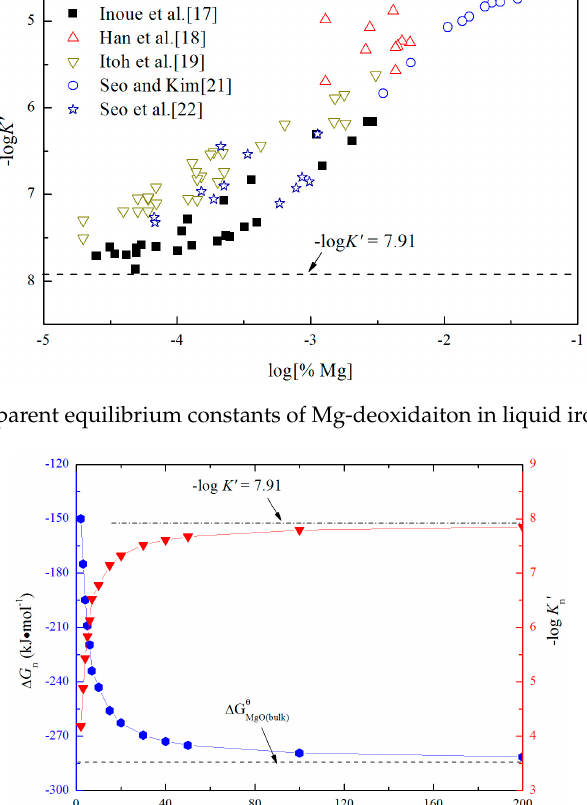
Figure 7. Solubility product of magnesium and oxygen and Gibbs free energy change for nano-magnesia forming in liquid iron at 1873 K.